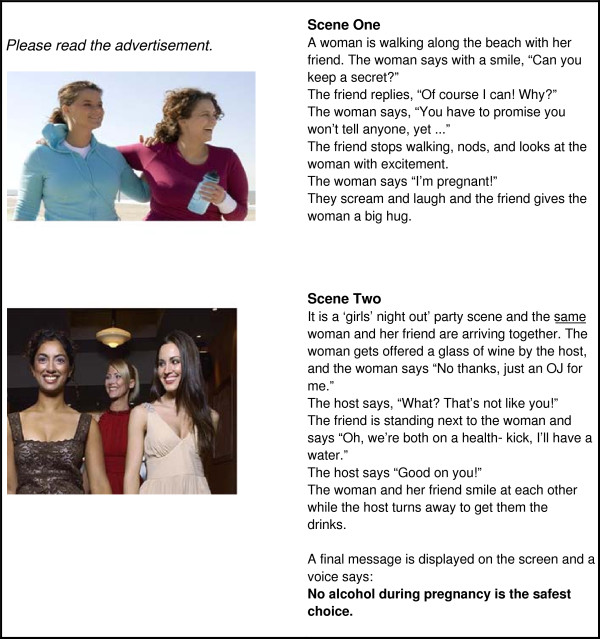
Self-efficacy only.